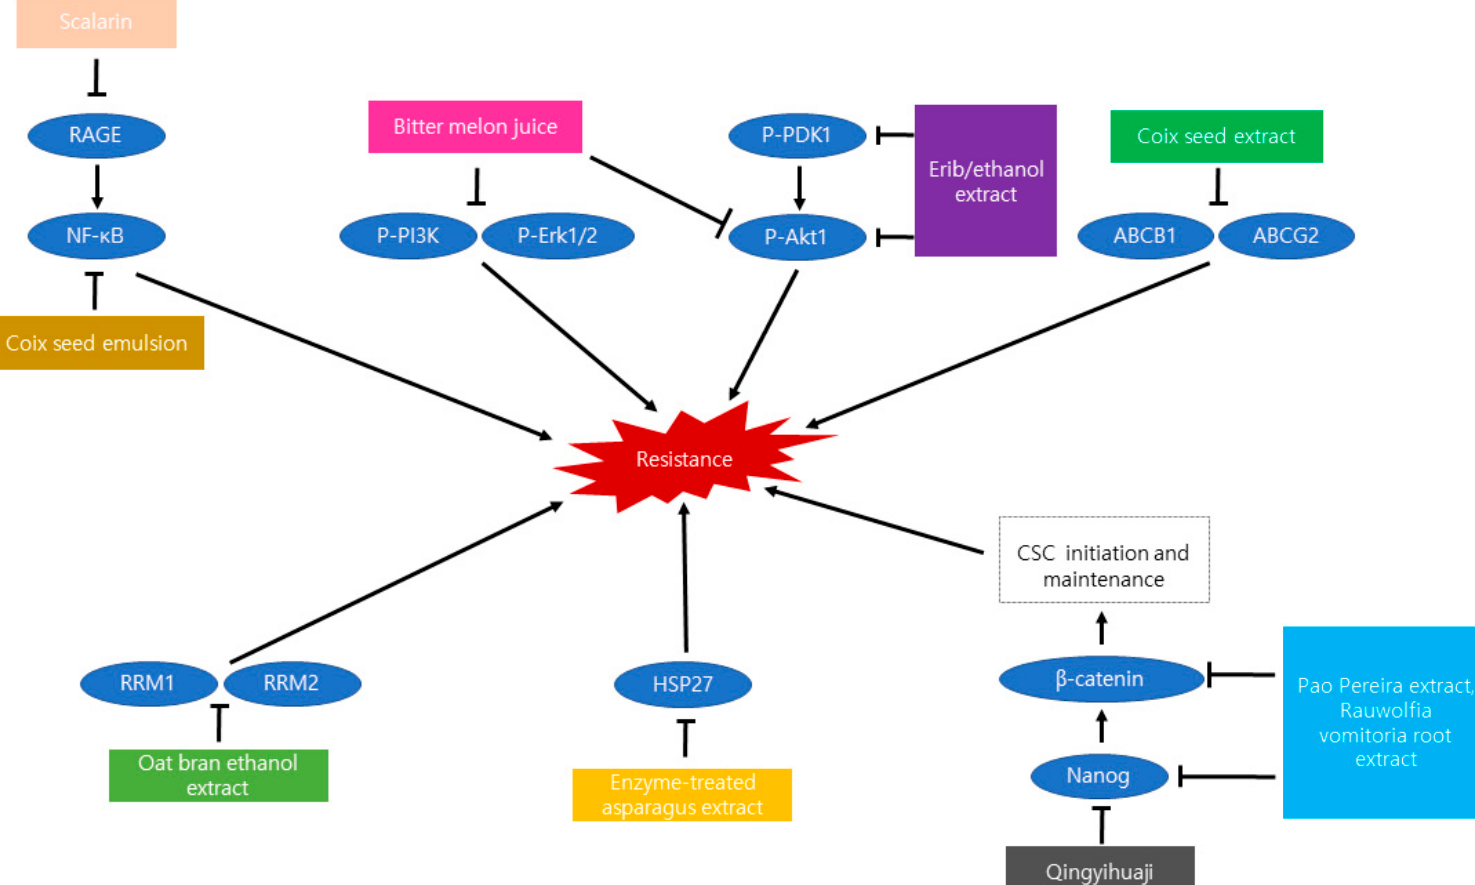
Figure 3. Schematic diagram of anti-resistance mechanisms of various natural products against pancreatic cancer.